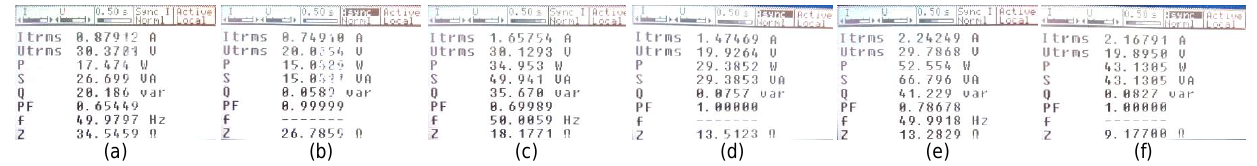
Figure 10. Powers, voltages and currents obtained for Case 1 – load supplied by ac voltage: (a) Input and (b) Output values for R o = 26 Ω; (c) Input and (d) Output values for R o = 13 Ω; (e) Input and (f) Output values for R o = 8.7 Ω.